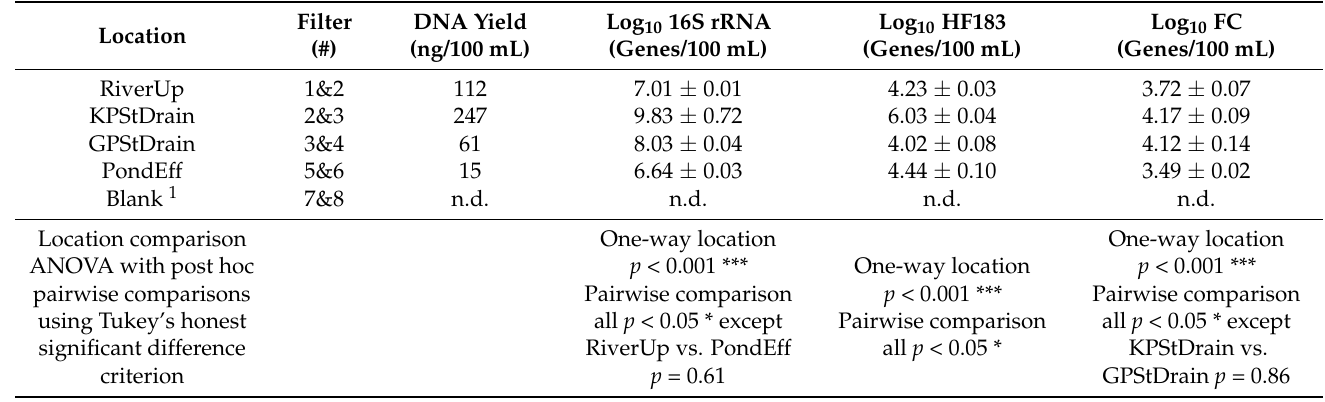
Table A4. DNA yield, 16S rRNA, HF183 gene copies, and fecal coliform (FC) counts for the water samples collected in the fieldwork and analyzed onsite. qPCR results are the average and standard deviation of triplicates prepared from each pooled DNA extract, while FC counts are for triplicates of the 0.5 mL water filtrations, * means significant at p < 0.05 and *** at p <